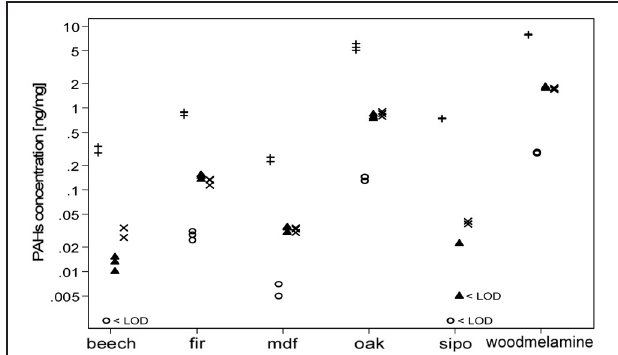
FIGURE 1 | Concentrations of total PAHs (crosses + ), BaP (open circles ◦ ), (cid:2) 6PAHs (filled triangles (cid:2) ), and pyrene (x) according to wood material generated during vibration sanding in the exposure chamber. < LOD = below the limit of detection.